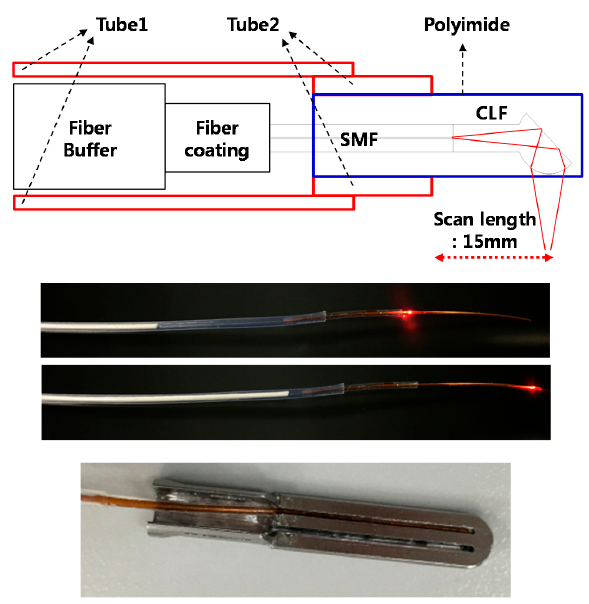
Figure 4. Optical sensing module for IGLaST.